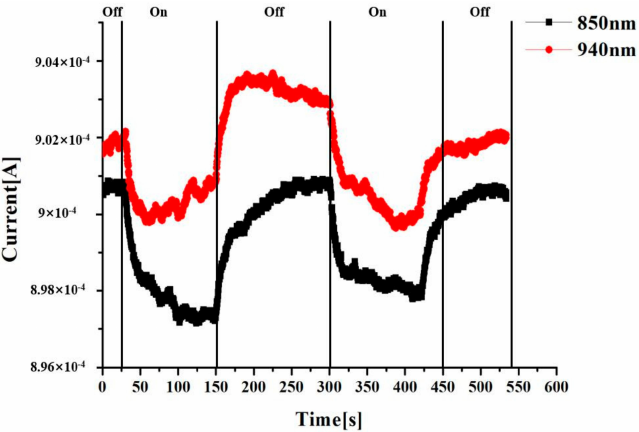
Figure 4. Current graph of graphene device irradiated intermittently of light with wavelengths of 850 nm and 940 nm,